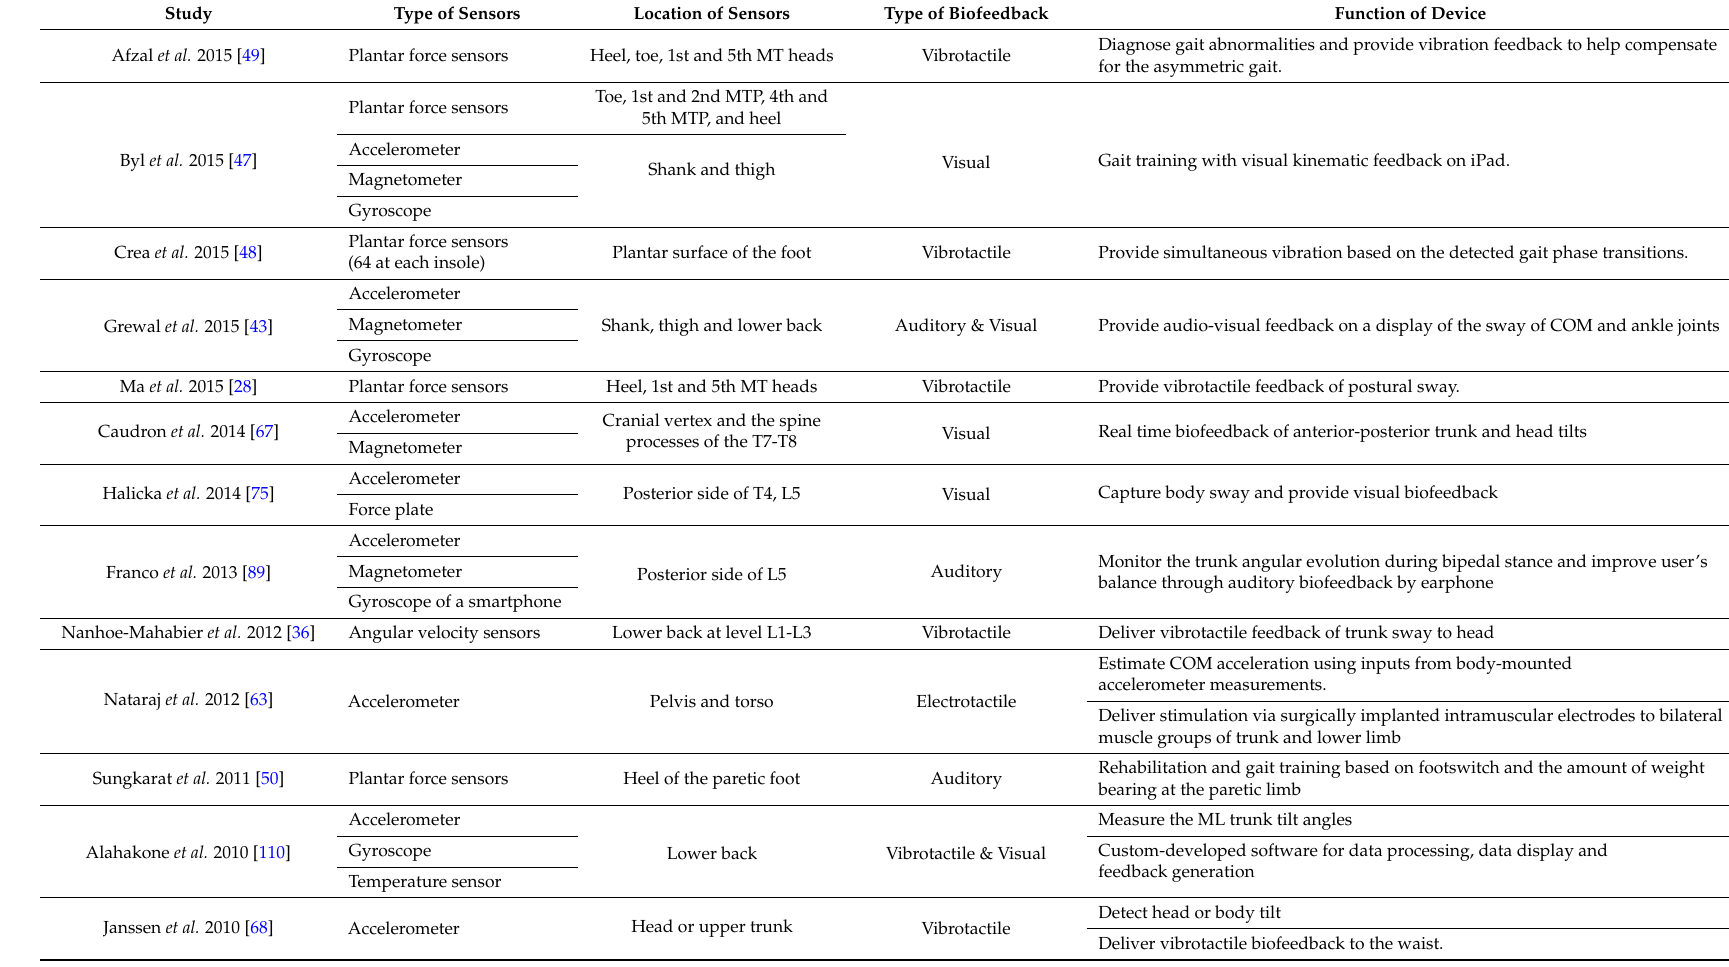
Table 8. Device characteristics ( n =